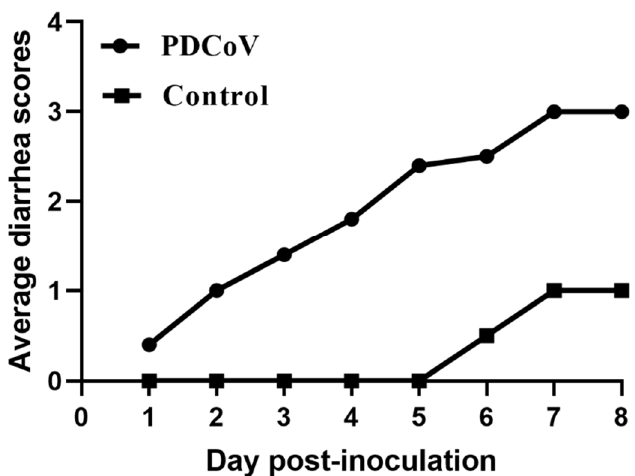
Figure 8. Diarrhea scores of the challenged piglets. The five-old-day piglets were inoculated orally with PDCoV CHN-SC2015 passage 12 and DMEM. Clinical signs were observed daily, and diarrhea was scored for challenged piglets as followed: 0 = normal feces,1 = soft, 2 = liquid with some solid content,3 = watery with no solid content.